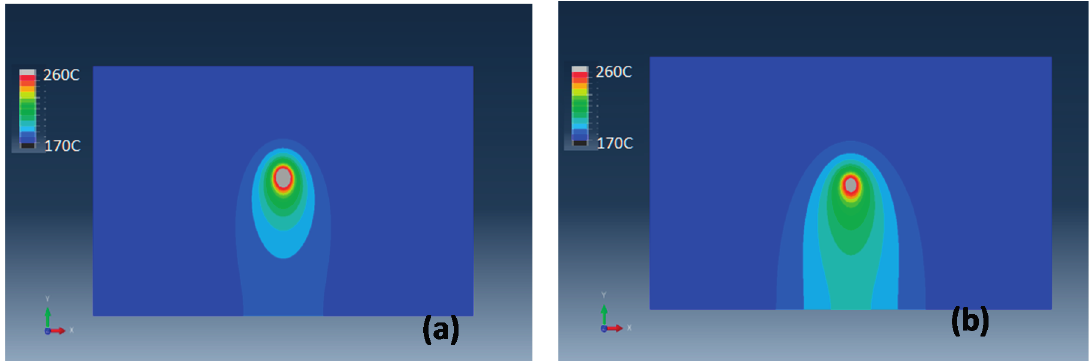
Figure 3. Temperature distribution of ( a ) PA12 and ( b ) PA12-CNT at x - y